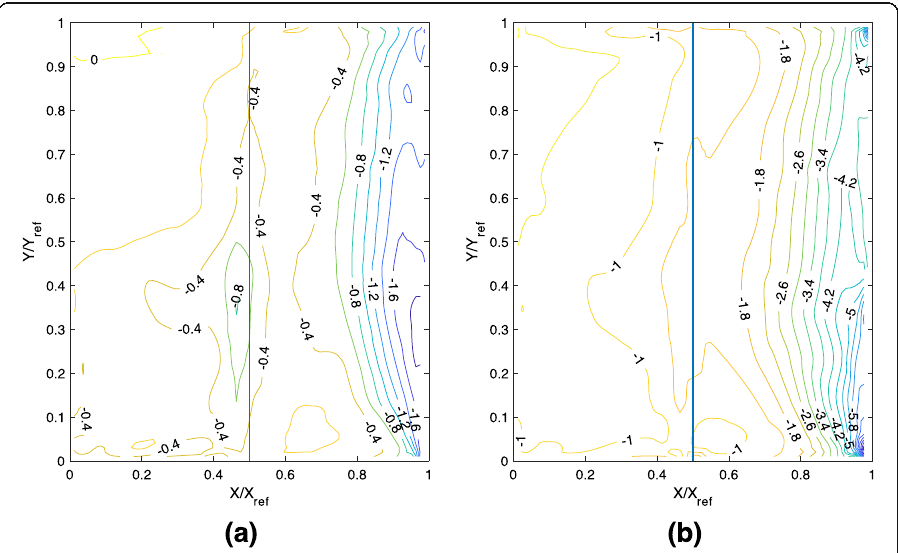
Fig. 16 Contours of roof pressure coefficients ( θ = 90 deg.), for the no parapet case: ( a ) mean Cps, and ( a ) 95% quantile peak